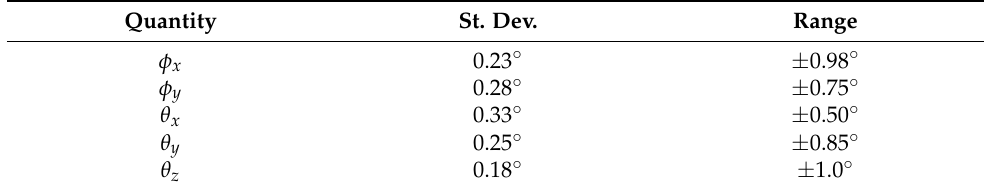
Table 1. The first two lines report the apparent rotation of (cid:126) m when the system is freely moved in the room and the magnet is in the z = 10mm plane, oriented along z , in a fixed position with respect to the sensor frame. Rotations around x and y are evaluated accordingly to Equation (5) (the system is blind to rotations around z ). The results are analyzed in terms of standard and maximal deviation. Conversely (last three lines), the apparent rotation of (cid:126) B geo is evaluated when the sensor array is fixed and the magnet (oriented along z ) moves on a circle 10mm in radius on the z = 10mm plane. These estimates are just exemplifying numbers, as the results depend on several features of the working conditions (ambient field inhomogeneities, accuracy of the sensor calibration, free motion applied to the system) that assume typical but non-reproducible values. Quantity St. Dev. Range φ x 0.23 ◦ ± 0.98 ◦ φ y 0.28 ◦ ± 0.75 ◦ θ x 0.33 ◦ ± 0.50 ◦ θ y 0.25 ◦ ± 0.85 ◦ θ z 0.18 ◦ ± 1.0